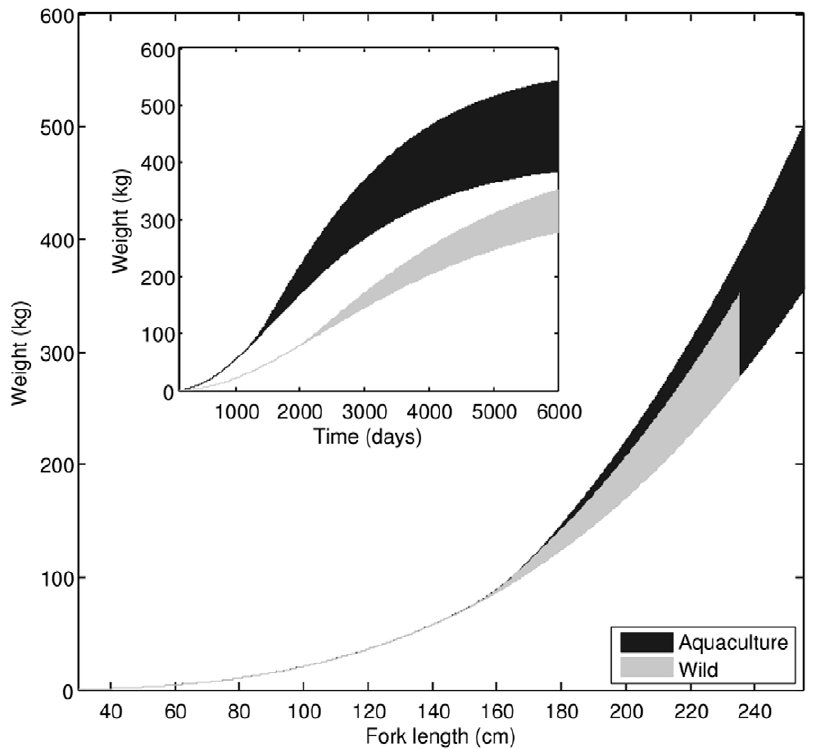
Figure 11. Comparison of weight-length relationships between cultivated and wild PBT as predicted by the model. Overlap of shaded areas indicate that for practical purposes these relationships are indistinguishable. Weight as a function of time, however, is quite different for cultivated and wild PBT (inlet).